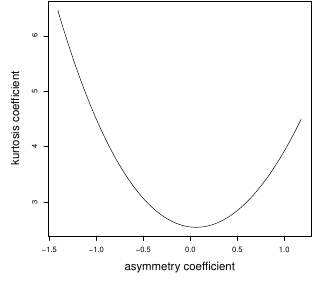
Figure 3. Graph of asymmetry coefficient versus kurtosis